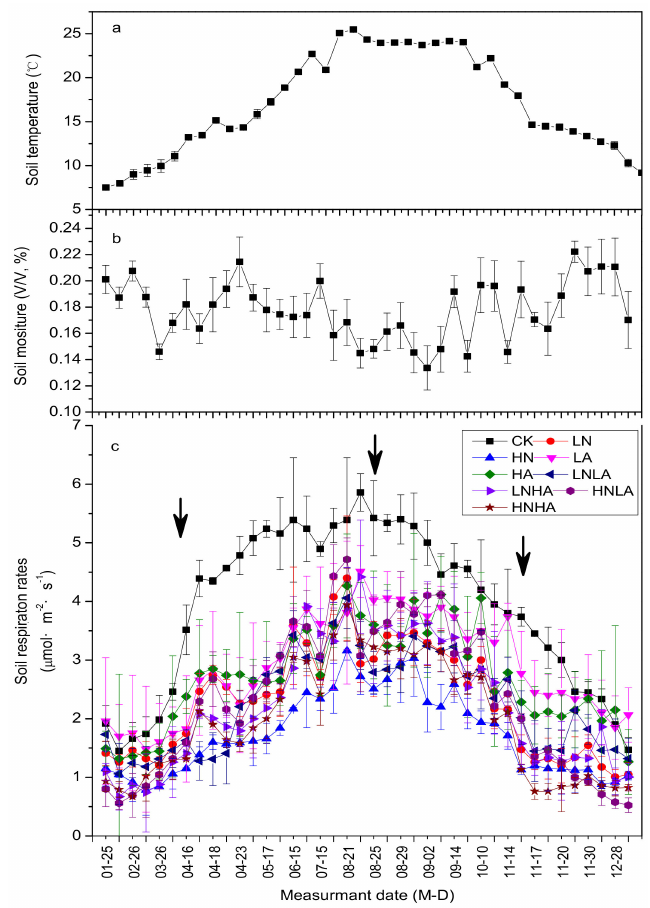
Figure 2. Monthly dynamics of soil temperature at a 5 cm soil depth ( a ), soil water content at a